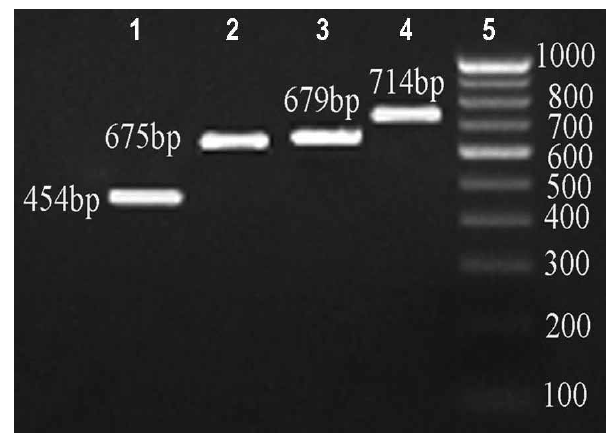
Figure-5: ScreeningoffieldisolatesfordetectionofMethicillin resistance of Staphylococci using primers targeting mec A gene. Lane 3: Negative isolate, Lane 1, 2, 4, 5: Positive isolate, Lane 6: DNA ladder.